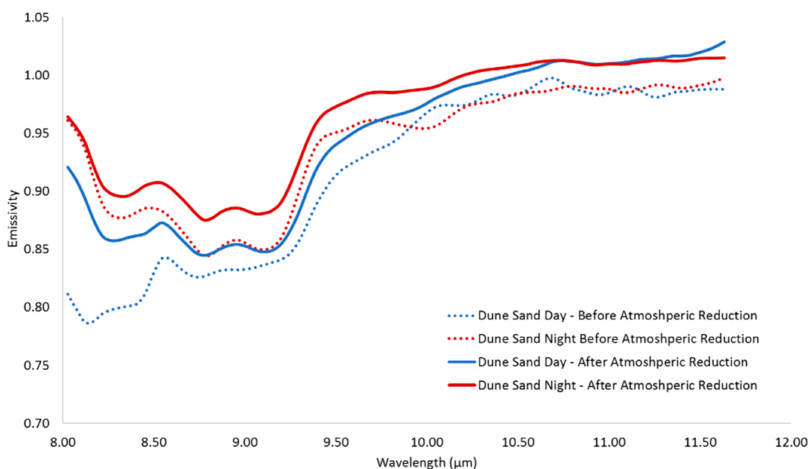
Figure 4. Day and night emissivity spectra of a pixel from a sand dune before applying the gain spectrum (pseudo emissivity, dashed curves) and afterwards (apparent emissivity, solid curves).